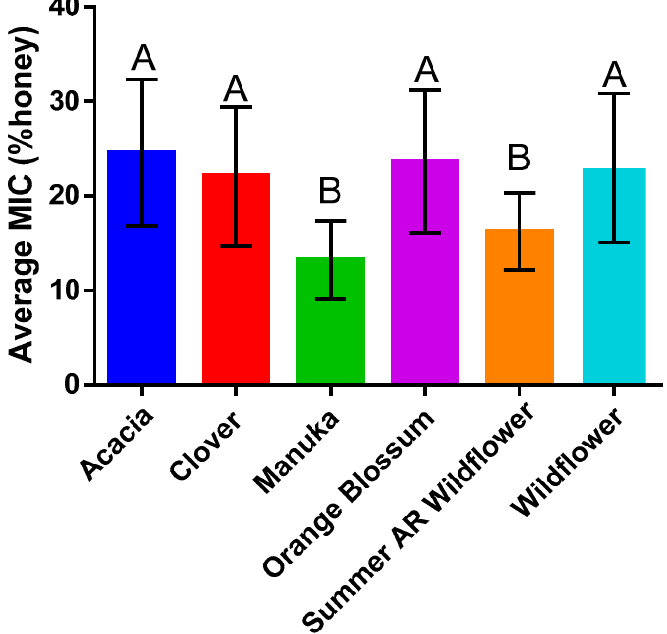
Figure 2. Comparison of honey type ( n = 46) and average MIC for all bacteria species ( n = 7). There was a significant effect of honey type on average MIC (Kruskal–Wallis, X 2 = 102.8, df = 5, p < 0.0001) (mean ± SD). Overall, manuka ( n = 12) and summer Arkansas wildflower ( n = 9) had the highest efficacy and demonstrated statistical equivalence in comparison to the poorest performing honeys, acacia ( n = 5), clover ( n = 6), orange blossom ( n = 7), and wildflower ( n = 7), which were not statistically different from one another. These results highlight how floral source differences impact microbial inhibition and suggest that manuka and summer Arkansas wildflower are comparable in antimicrobial efficacy despite their differences in floral source (Dunn’s, Supplemental Table S1). Columns with equivalent letters (e.g. A and A) are statistically similar while columns with different letters (e.g A and B) are statistically different.